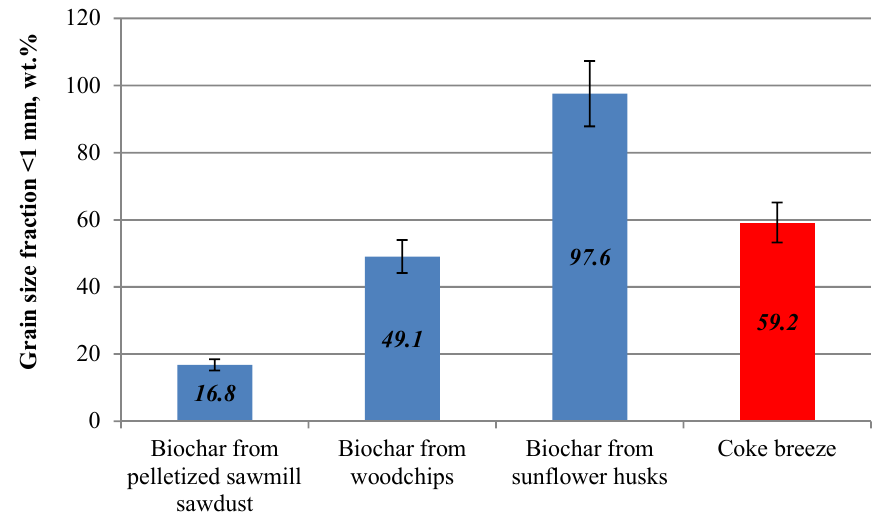
Figure 5. The share of undesired grain size fraction <1 mm for particular biochars and coke breeze. The smallest size of grains was measured for biochar from SH, for which the average grain size was equal to 0.28 mm, while the share of fractions <1 mm reached ca. 98 wt.%. The biochar from WdC was characterized by grain size similar to CB, with average value equal to 1.26 mm (for CB it was 1.45 mm). However, the share of smallest grain fraction <1 mm was slightly lower than in the case for coke breeze, and reached ca. 50 wt.% (60 wt.% for CB), which was advantageous. The best granularity with regard to sintering process preferences was obtained for biochar from residual SDP. Its average grain size reached 3.37 mm, with a very low content of smallest grain fraction <1 mm of 17 wt.%. Such granularity of the fuel, according to literature data [18], was expected to positively influence the permeability of the sintering mixture.